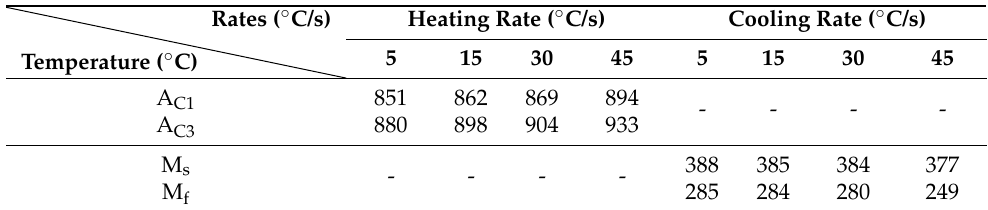
Table 1. Transformation temperatures of Gr. 92 WM determined by a dilatometer at specific heat- ing/cooling rates.